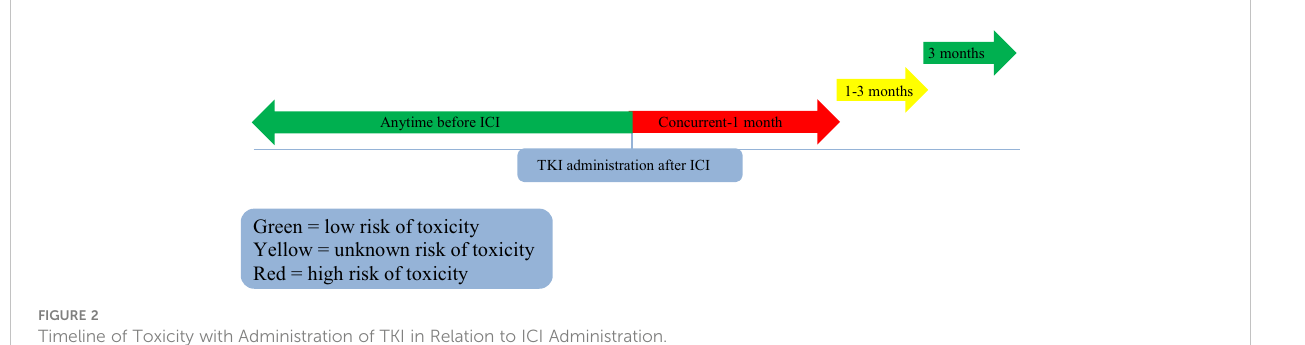
FIGURE 2 Timeline of Toxicity with Administration of TKI in Relation to ICI